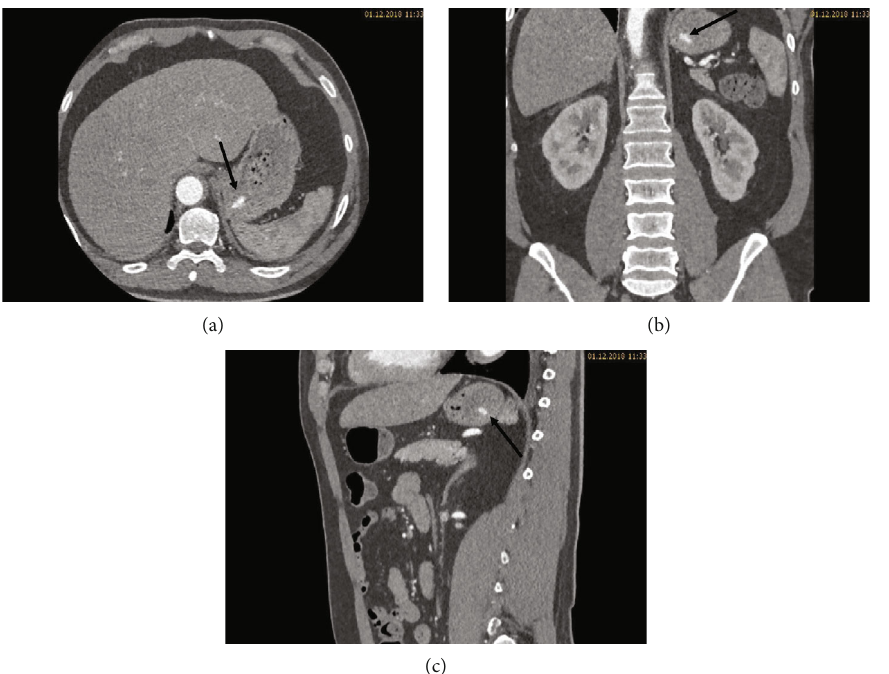
Figure 1: (a – c) Transversal, coronal, and sagittal slides of the abdominal CT in the arterial phase: a faint hyperdense lesion is seen in the posterior fundus of the stomach.